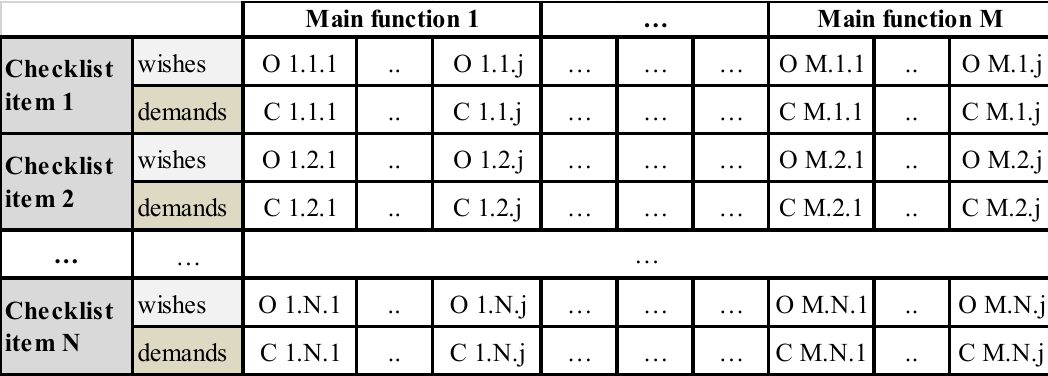
Figure 1. Generalized version of the matrix (N checklist items and M functions). The number of columns under each function can vary. Empty boxes are allowed when it is not possible to extract / infer relevant